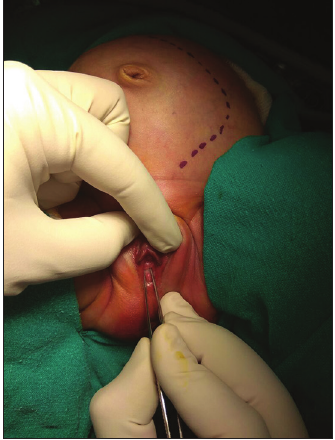
Figure 1: Marked abdominal lump and lower hymenal bulge